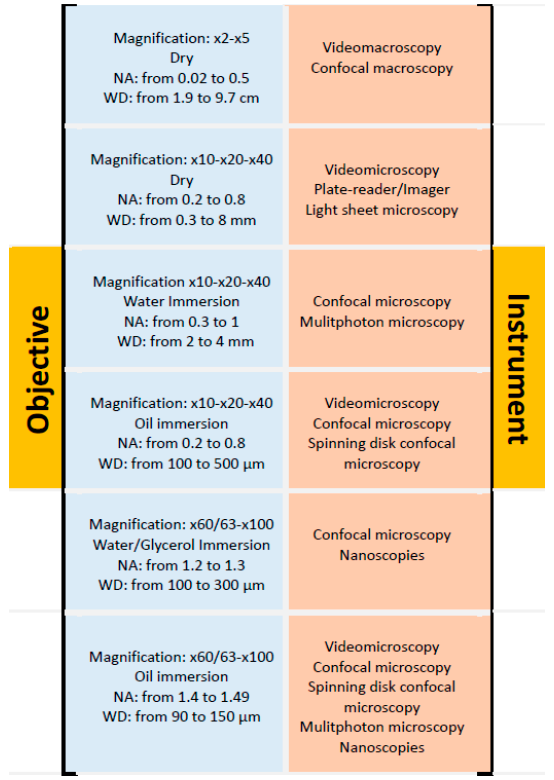
Figure 18. Characteristics of objectives used for live cell imaging. Special focus has been given to immersion medium, numerical aperture (NA), and working distance (WD).